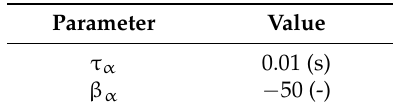
Table 3. Visco-hyperelastic model parameter values fitted from experimental data.